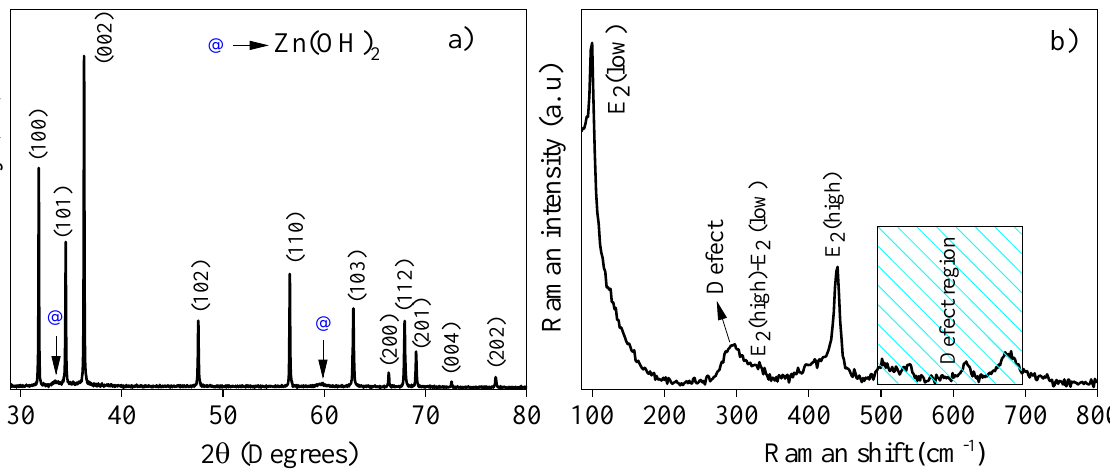
Figure 1. ( a ) X-ray diffraction pattern; ( b ) Raman spectrum for the Zn 0.94 Er 0.02 Cr 0.04 O compound. The lattice parameters ( a and c ) are calculated using the equation that correlates the interplanar spacing, Miller indices and the lattice constants for the ZnO with